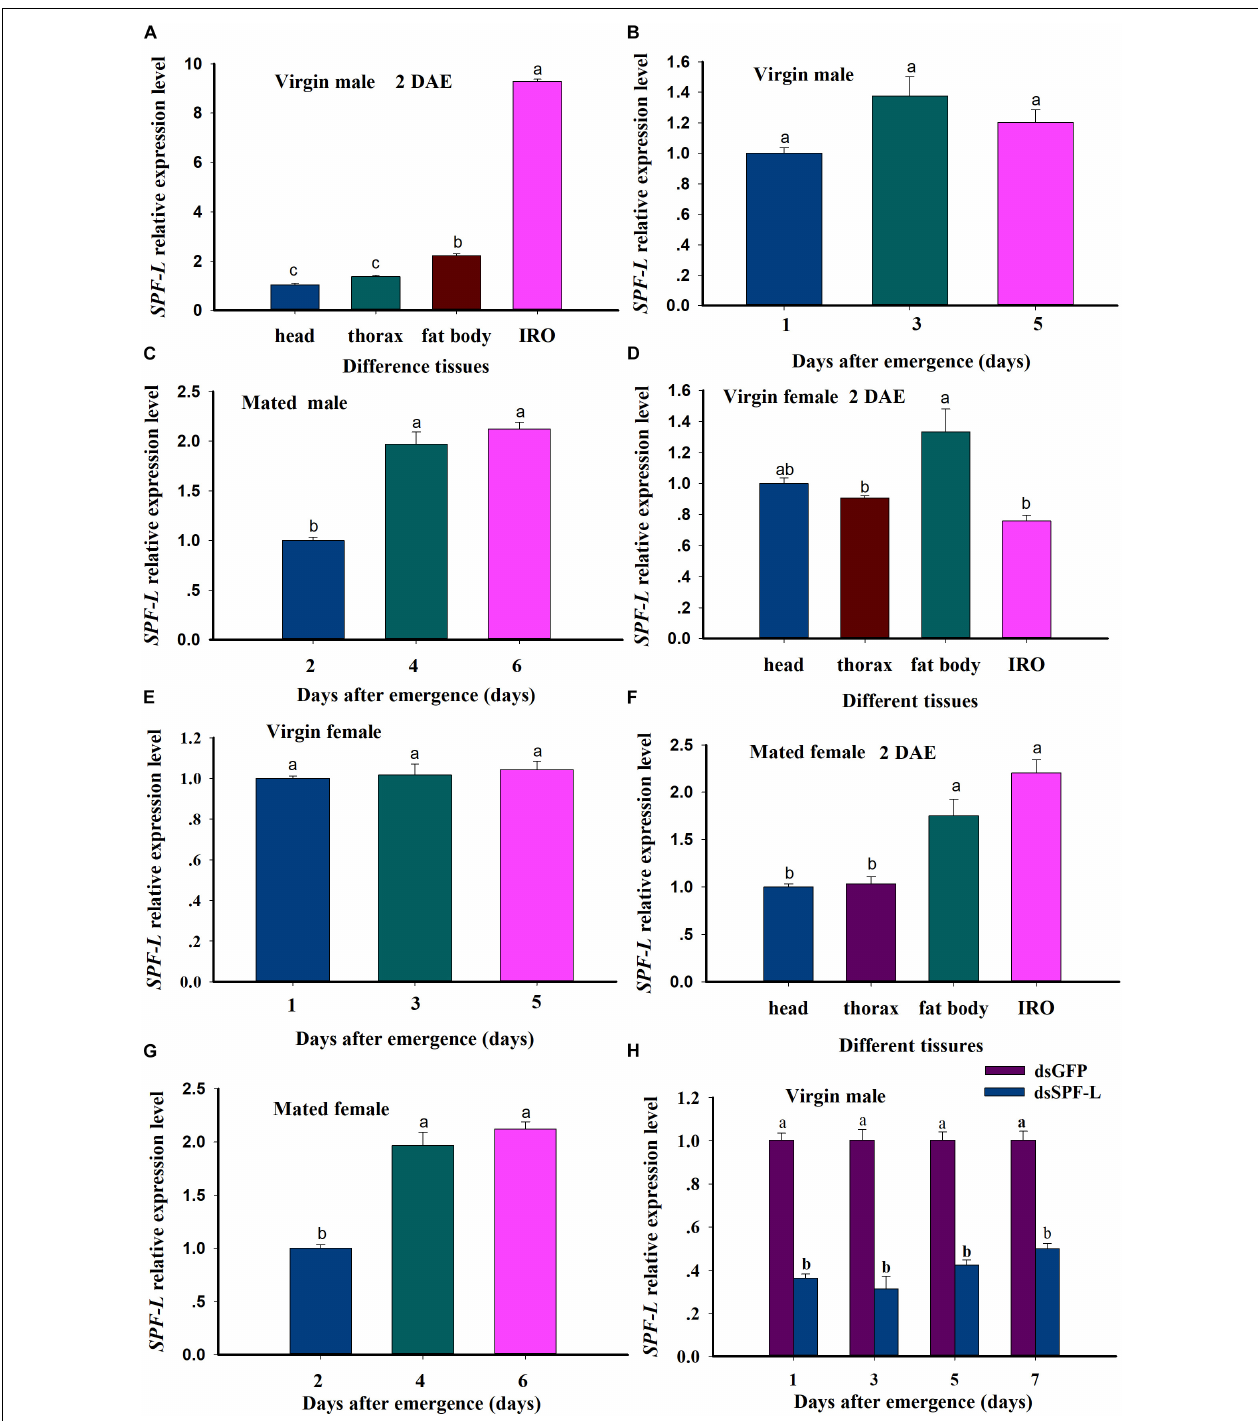
FIGURE 4 | Relative accumulations of mRNA encoding the BPH SPF-L. (A) The histogram bars indicate accumulations of mRNA in the indicated body segments and tissues of virgin male at 2 DAE. (B,C) The histogram bars indicate the mean SPF-L expression level in virgin males and mated males ( n = 5, N = 3). (D,E) The histogram bars indicate the mean SPF-L expression level in the tissues of virgin female ( n = 20, N = 3) and at 2, 4, 6 DAE in virgin female ( n = 5, N = 3). (F,G) The histogram bars indicate the mean SPF-L expression level in the tissues of mated female ( n = 20, N = 3) and at 2, 4, 6 DAE in mated female ( n = 5, N = 3). The error bars indicate one SEM. The mRNA expression value of adult female head was converted to 1. (H) The histogram bars show mean relative mRNA accumulation ( n = 5, N = 3 independent biological replicates) at 1, 3, 5, and 7 DAE in virgin males and the error bars represent one SEM. Gene expression was normalized to the β -actin reference gene. The histogram bars with different letters were significant difference at p < 0.05 (Student’s t -test).